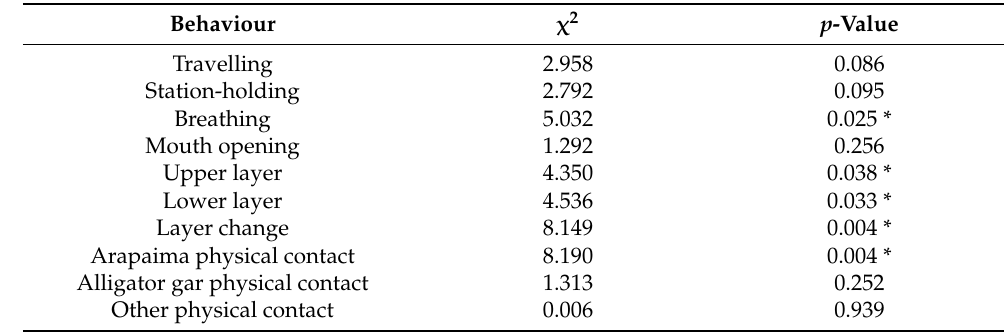
Table 6. Results of relative frequency (observed frequency/observation duration) likelihood ratio test comparing the two linear mixed models, one with and the other without the fixed effect (effect of the use of the green laser pointer).